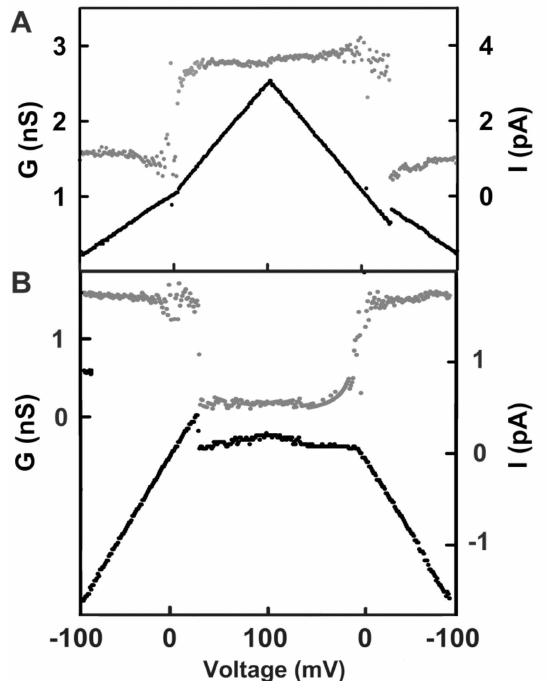
Figure 3. Gating pattern of channels 2 and 3. The membrane contained a single triplin, and by the time these segments were recorded, channel 1 had closed. Illustrated in each panel is the current recorded (lower trace, using the scale at the right) during one cycle of a triangular voltage ramp (31 mHz, ± 100 mV). The upper trace (gray dots) is the calculated conductance, using the scale at the left. ( A ) Opening and closing of channel 2. Note that channel 2 closure took place at negative potentials, whereas the reopening, being kinetically delayed, occurred at a slightly positive voltage. ( B ) Closing and opening of channel 3 when channels 1 and 2 remained closed. Channel 3 closed at positive voltages, and the remaining conductance was close to